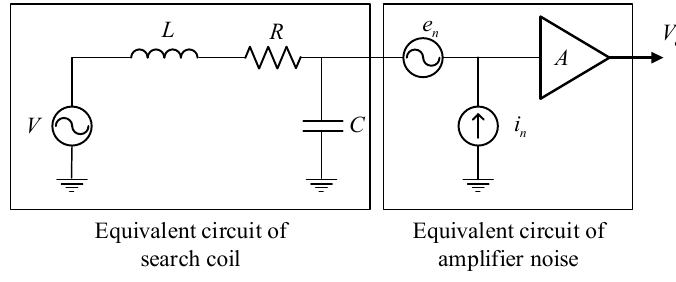
Figure 5. Equivalent circuit of search coil Figure 5 . Equivalent circuit of search coil sensor.